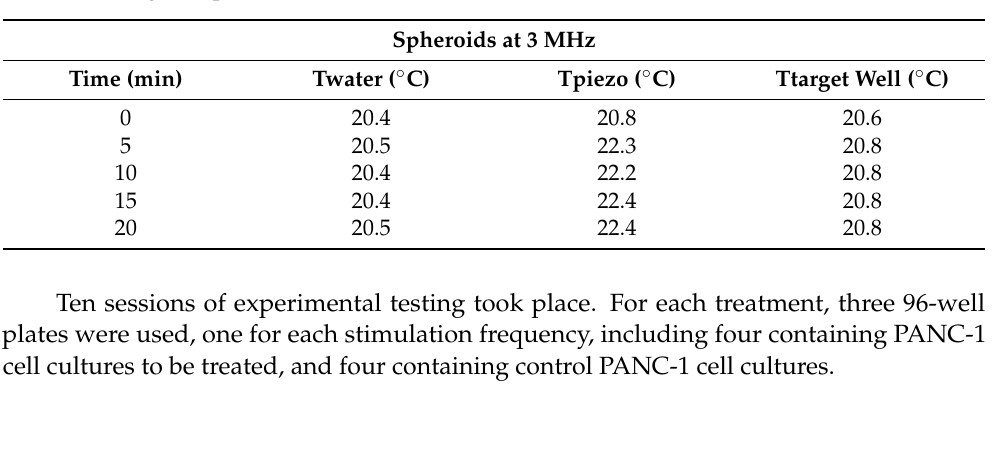
Table 3. Average temperature values calculated at 3